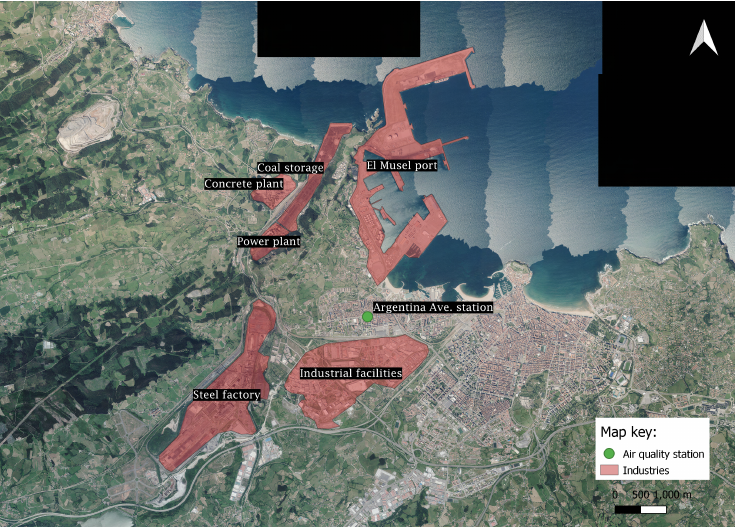
Figure 1. Location of the air quality station, which provided the data for this study, and the main industrial sites in